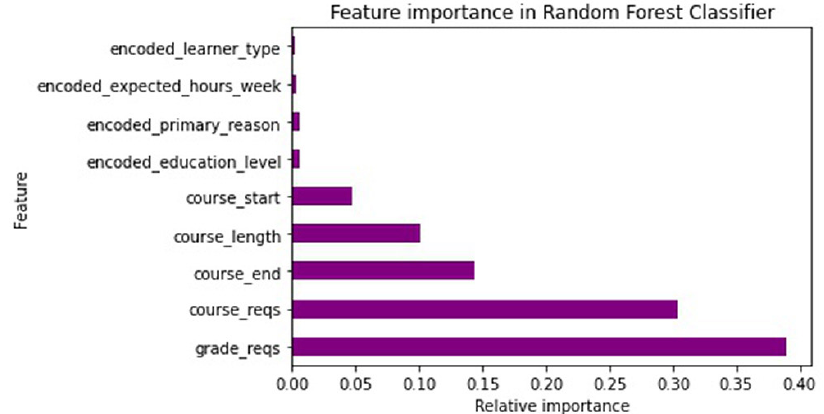
Fig. 10. Learner and MOOC features’ importance from the Random Forest